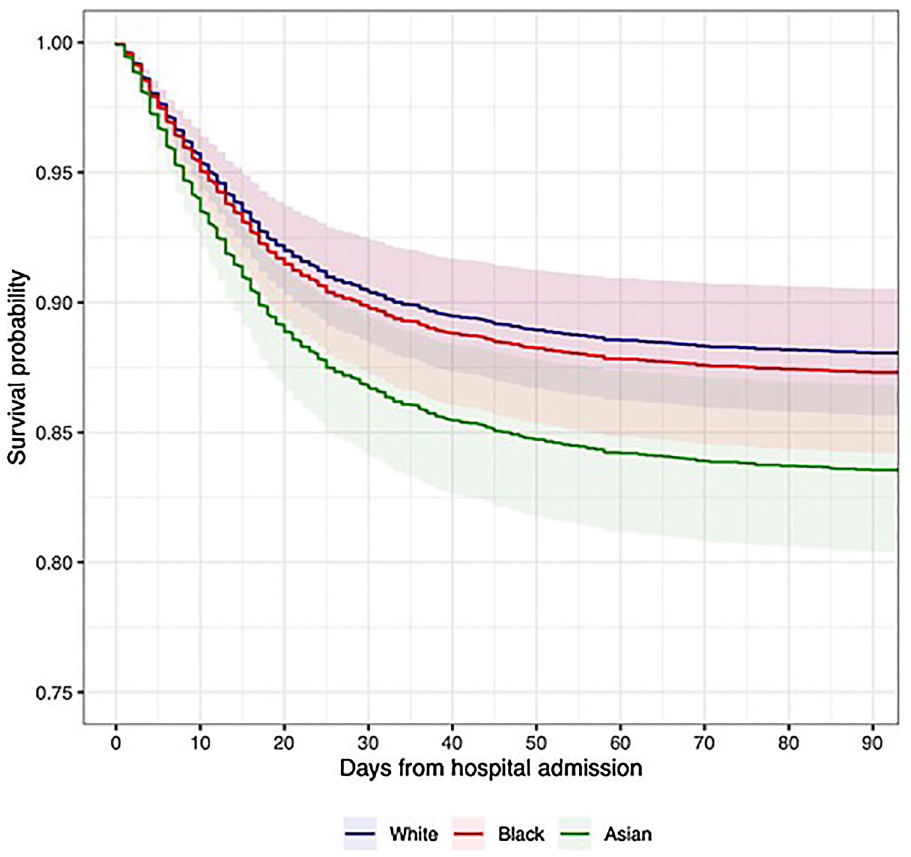
Figure 2. Predicted survival over 90-days by Ethnicity in a 65-year-old Male living in IMD-3 without Diabetes, CKD, Smoking History, Hypertension or Obesity. Based on second wave Cox-proportional Hazard analysis included covariates: Age, Sex, Hypertension, Diabetes, Chronic Kidney Disease, Smoking history, Obesity, IMD (quintiles of local study